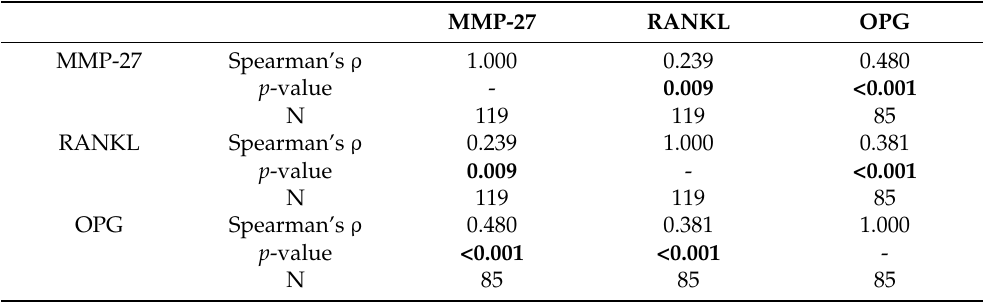
Table 3. Correlation analysis of MMP-27, RANKL and OPG co-expression in our cohort. Significant results highlighted in